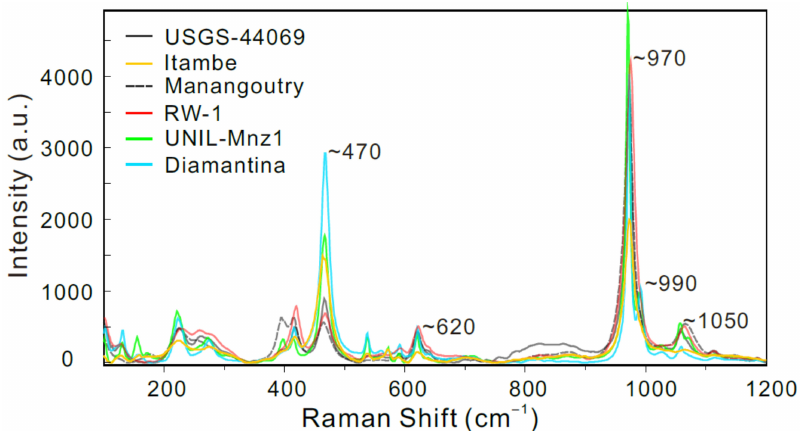
Figure 1. Raman spectra of monazite reference materials. The main monazite Raman bands are found at ~470, ~620, ~970, and ~1050 cm − 1 , and the lattice vibrations are found at < 430 cm − 1 [36,37]. The UNIL-Mnz1 and Diamantina monazite standards have an additional band at ~990 cm − 1 . The Itambe monazite has an ambiguous band at ~1050 cm − 1 .